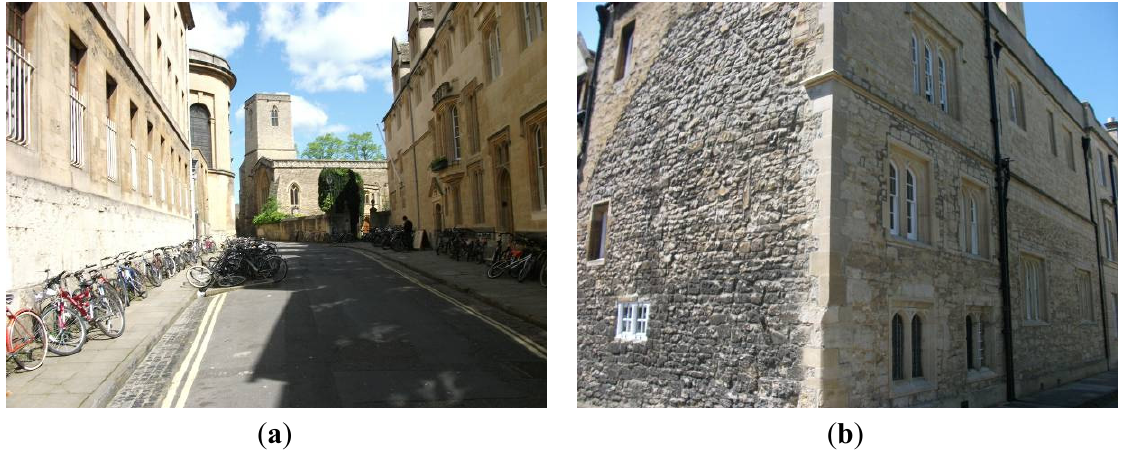
Figure 3. Both sides of lane-way at the entry from High Street, showing ( a ) Queen’s College (left) and St Edmund Hall (right) as well as ( b ) behind Hertfort College from the lane-way.